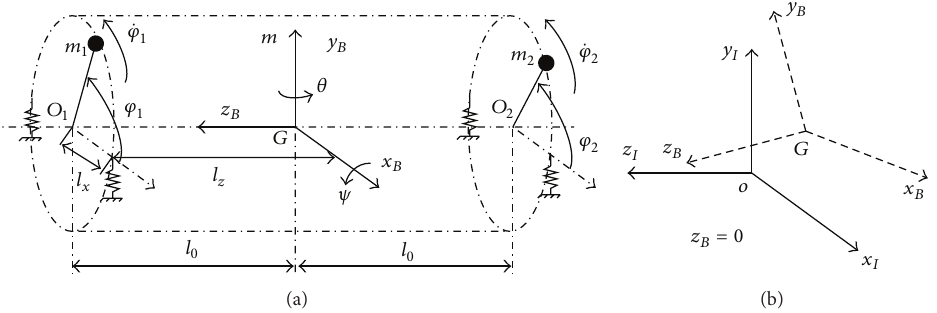
Figure 1: Dynamical model of the vibration system: (a) schematic diagram of structure; (b) the coordinate frames: 𝐸 𝐼 = {𝑂 𝑥 𝐼 𝑦 𝐼 𝑧 𝐼 } , the earth fixed inertial frame, 𝐸 𝐵 = {𝑂 𝑥 𝐵 𝑦 𝐵 𝑧 𝐵 } , the body fixed